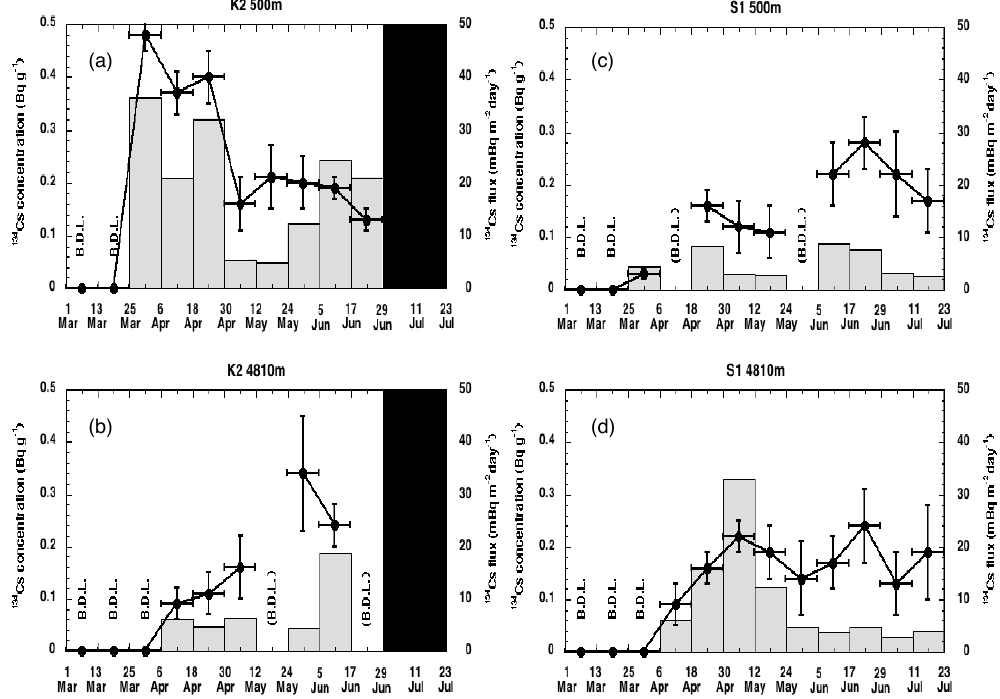
Fig. 3 (Honda et al) Fig. 3. Variability of 134 Cs concentration (line graph) and 134 Cs flux at (a) K2-500m, (b) K2-4810m, (c) S1-500m and (d) S1-4810m. B.D.L. is below detection limit. B.D.L. in parenthesis is supposed to be below detection limit likely caused by insufficient sample mass and radiocesium for gamma ray